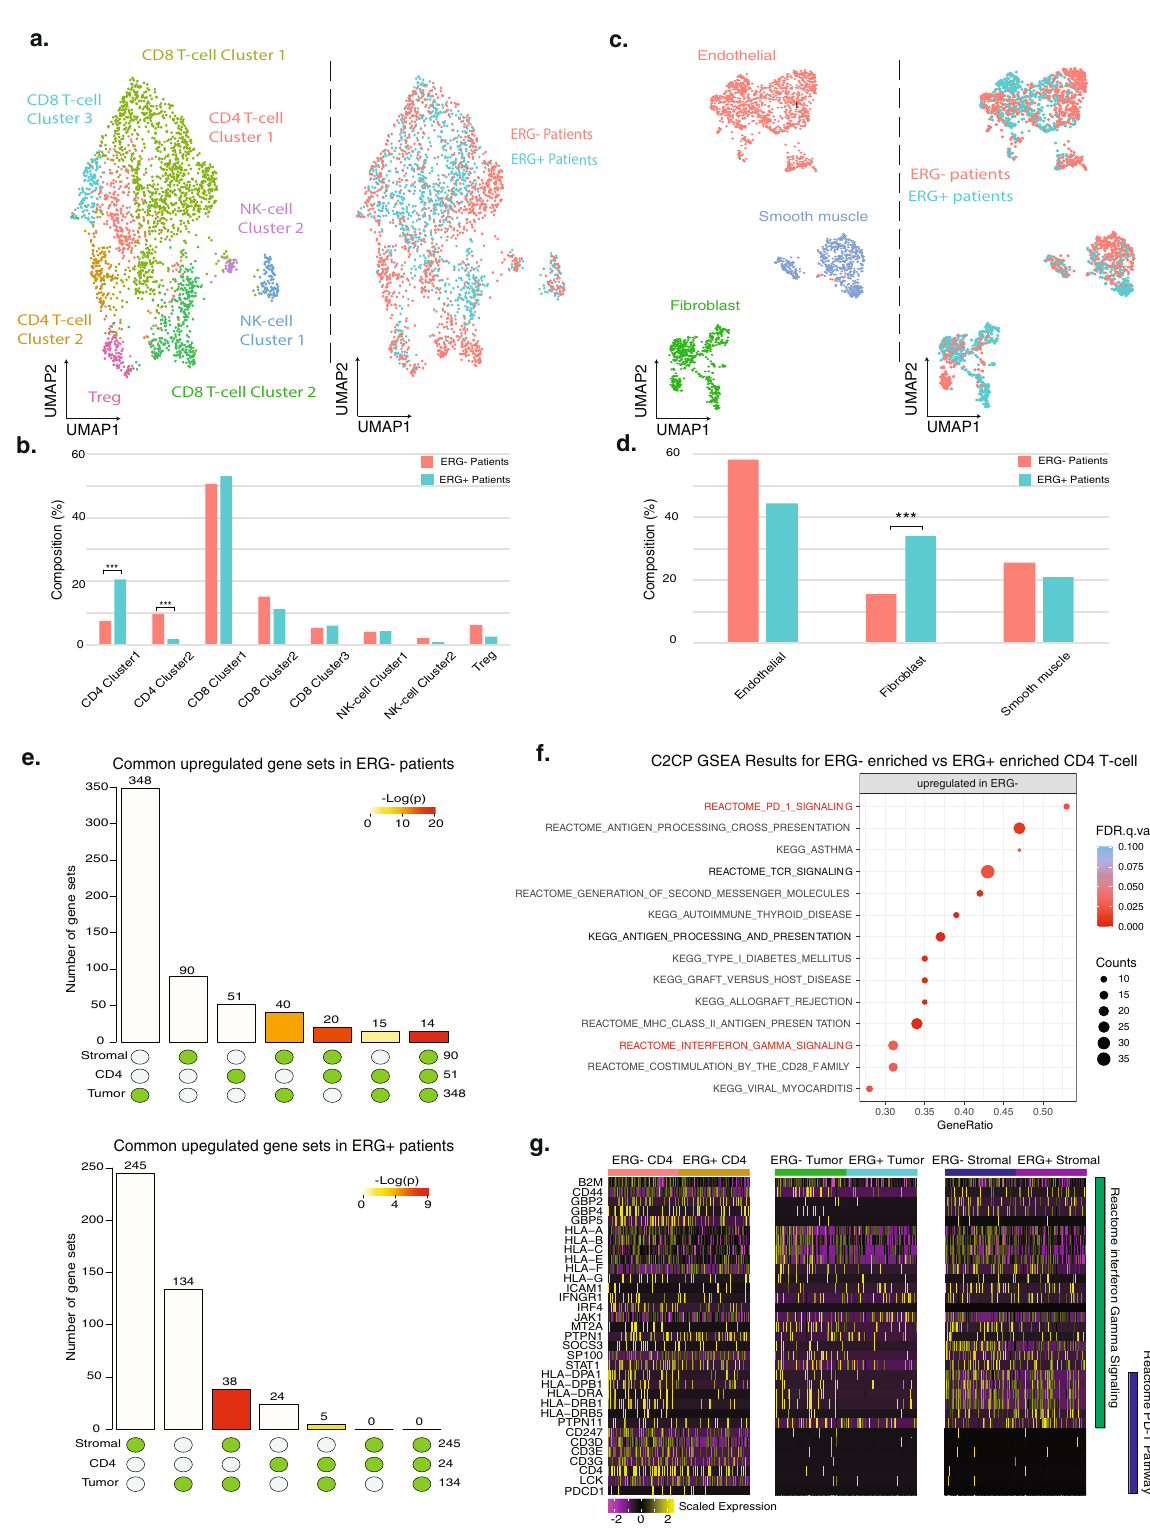
yielded 23 clusters from a total of 15,073 cells. We identi fi ed a total of six epithelial cell types with distinctive DEGs, based on cell-type signatures we generated from PCa tissue samples and established signatures from normal samples (Supplementary Data 2) (Fig. 8a), including BE cells characterized by high expression of DST , KRT15, KRT5, KRT17 , and TP63 , club cells characterized by PIGR, MMP7, CP , and CEACAM6 , hillock cells,